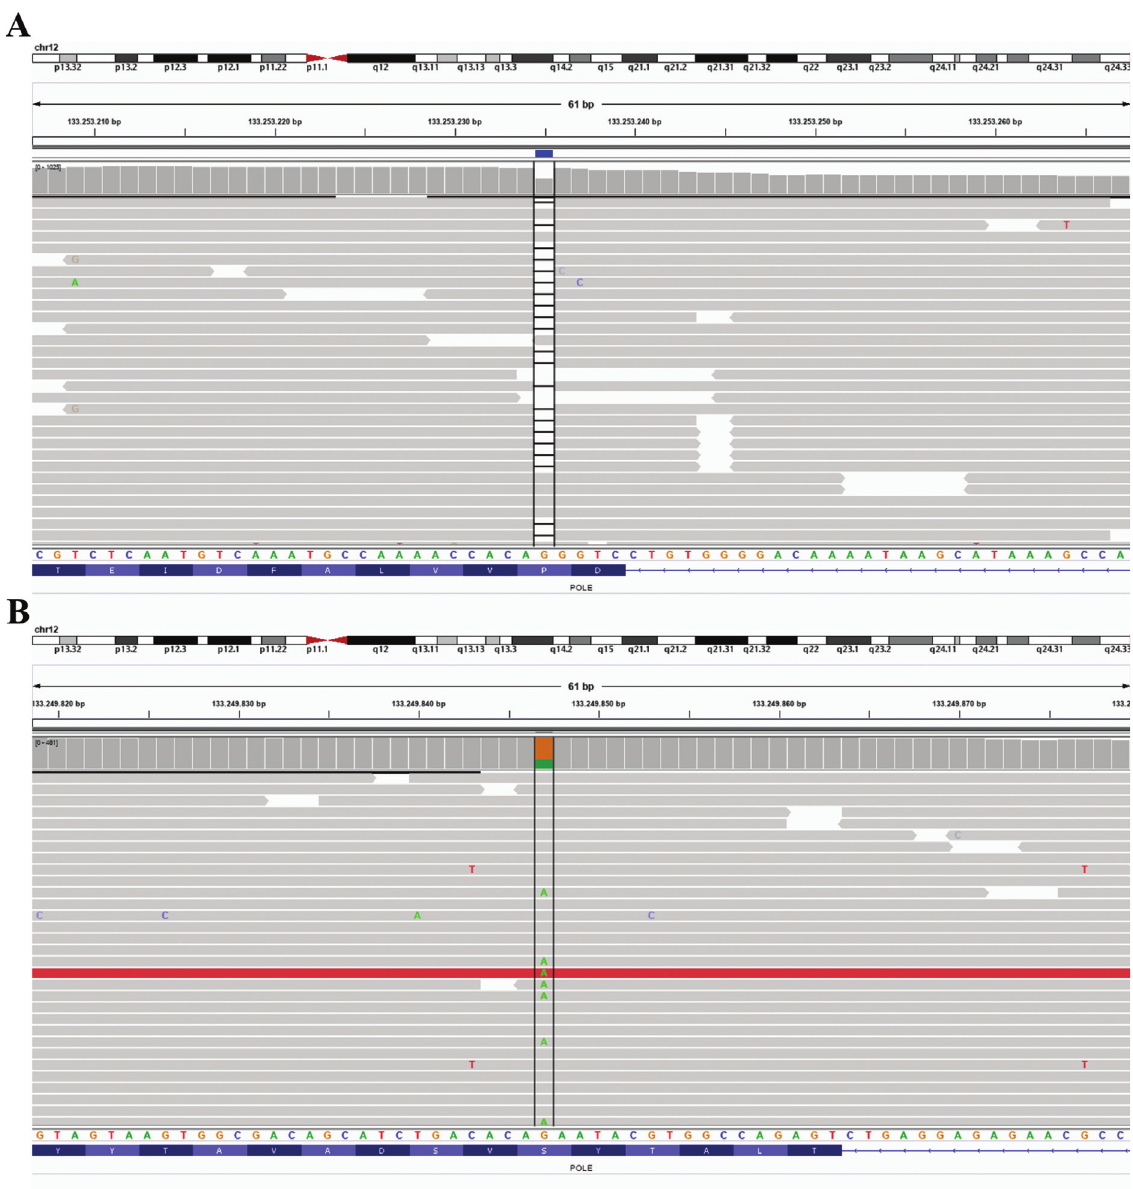
Figure 1 - Integrative Genomics Viewer snapshot of POLE mutations with reference POLE nucleotide and amino acid sequences. (A) germline frameshift c.806delC and (B) somatic c.1376C>T (S459F) exonuclease